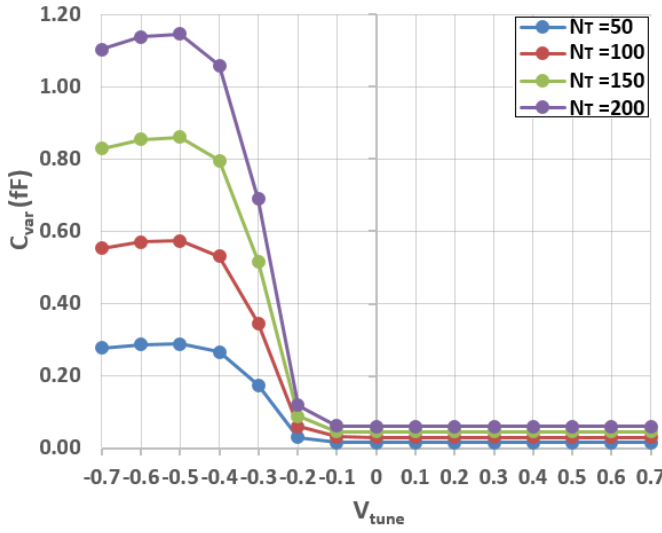
Figure 9. CV characteristics of varactor with different N T .